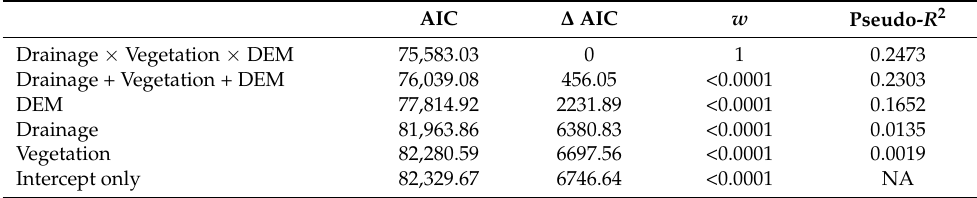
Table 6. Fitted Poisson point process models with AIC, Δ AIC, Akaike weights ( w ) and pseudo- R 2 . AIC ∆ AIC w Pseudo- R 2 Drainage × Vegetation ×